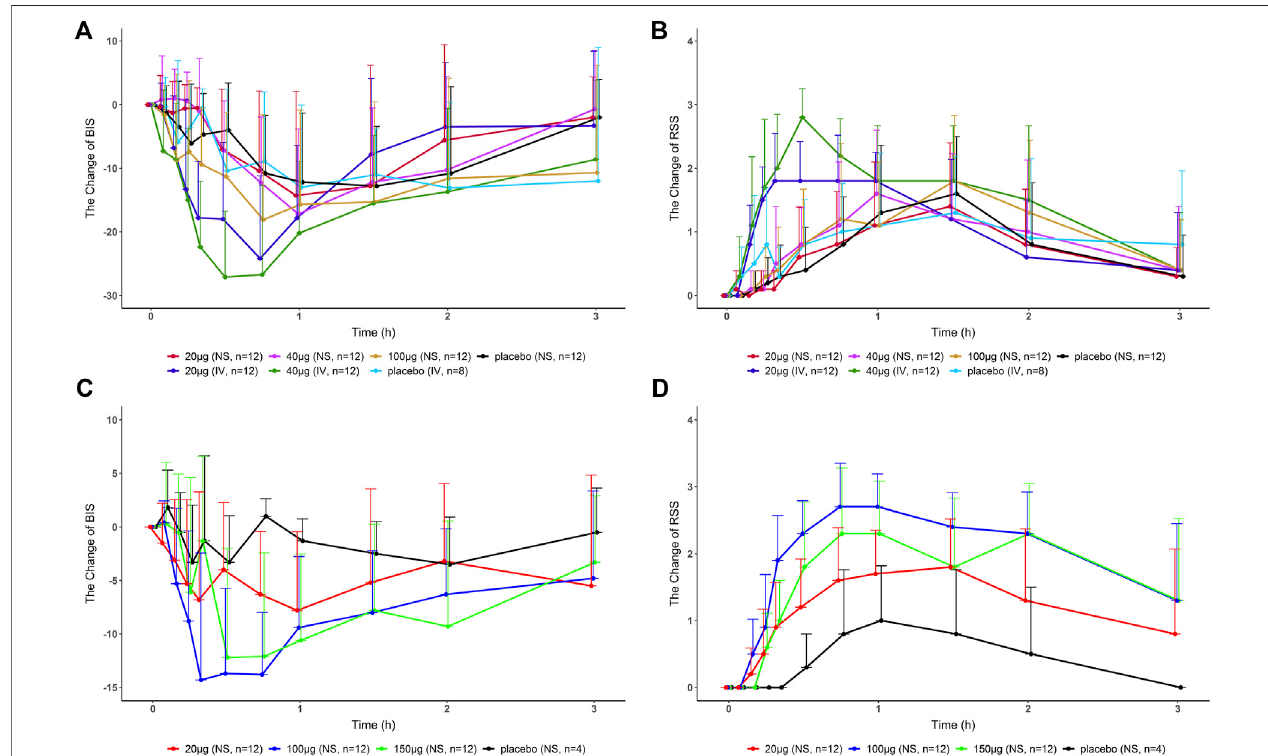
FIGURE2| ChangeinBIS/RSSvaluescomparedwiththebaseline-timecurvesinhealthysubjectsafterasingledoseofdexmedetomidinenasalspray,injection,or placebo. (A) , (B) Part 1. (C) , (D) Part 2, and Part 3. BIS, bispectral index; RSS, Ramsay sedation score; NS, nasal spray; IV, intravenous.